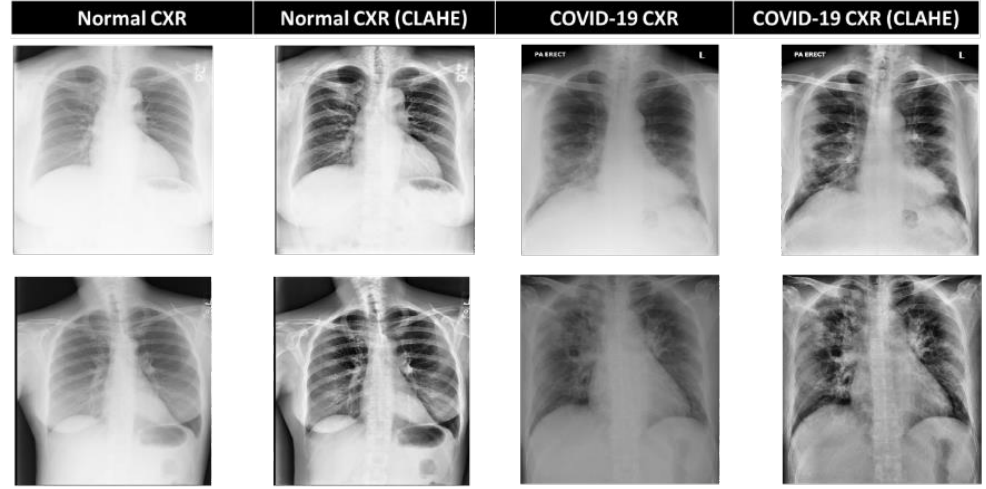
Figure 2. Sample scans before and after image enhancement.